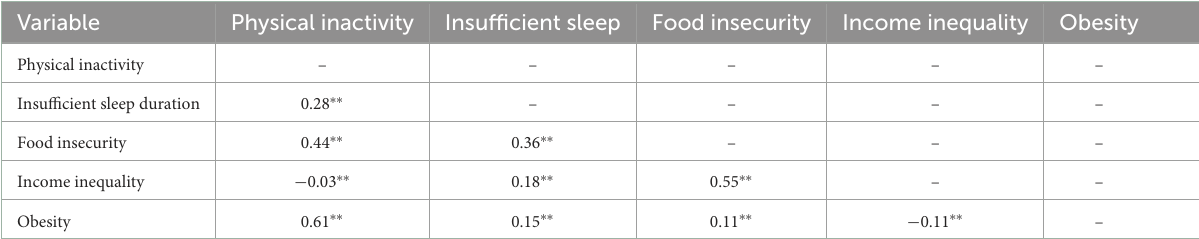
TABLE 2 Path analysis direct effects.